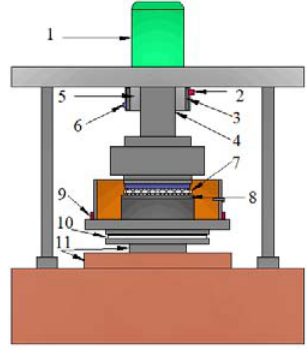
Figure 1. Schematic of the rolling contact fatigue test device. 1-DC motor, 2-Coolant outlet, 3-Coolant inlet, 4-Spindle, 5-Spindle bearing, 6-Circulating coolant chamber, 7-Bearing, 8-Specimen, 9-Heating sheet, 10-Rolling bearing, and 11-Hydraulic cylinder.